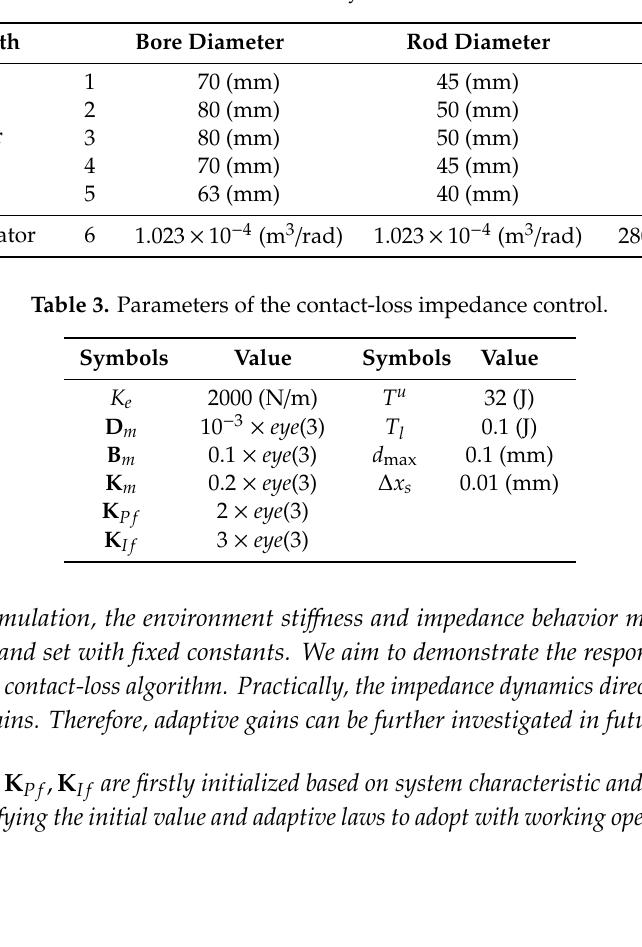
Table 2. Parameters of hydraulic actuators.